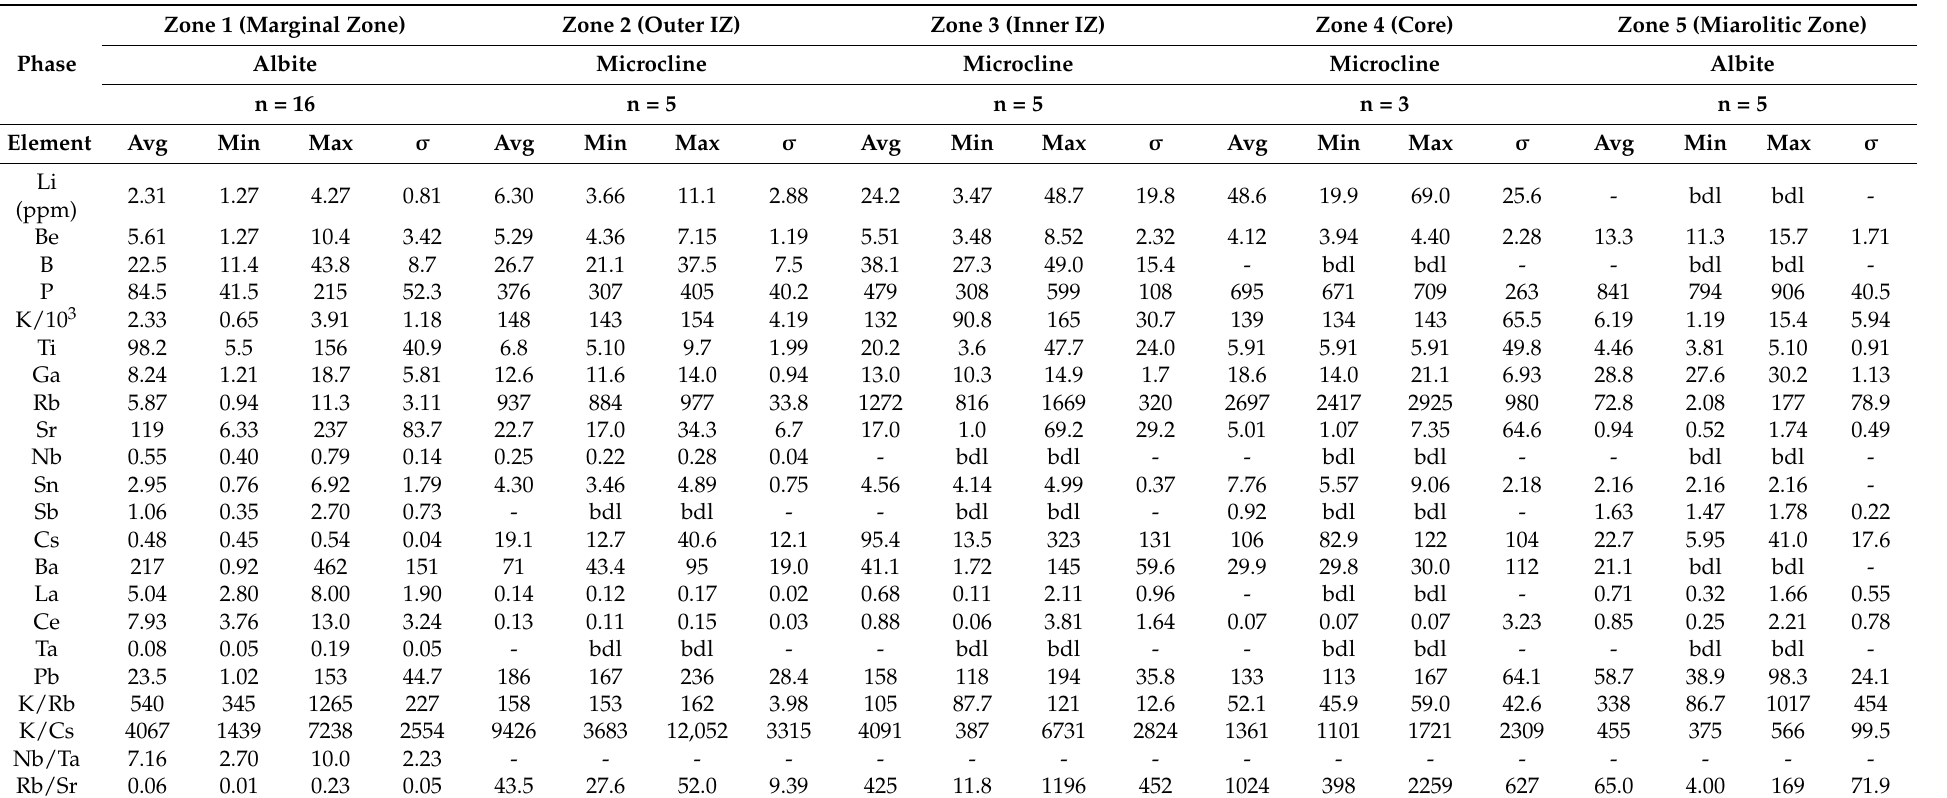
Table 4. The average LA-ICP-MS trace element composition of alkali feldspar from the Yamrang Pegmatite, Ikhabu Pegmatite Field (IPF), Eastern